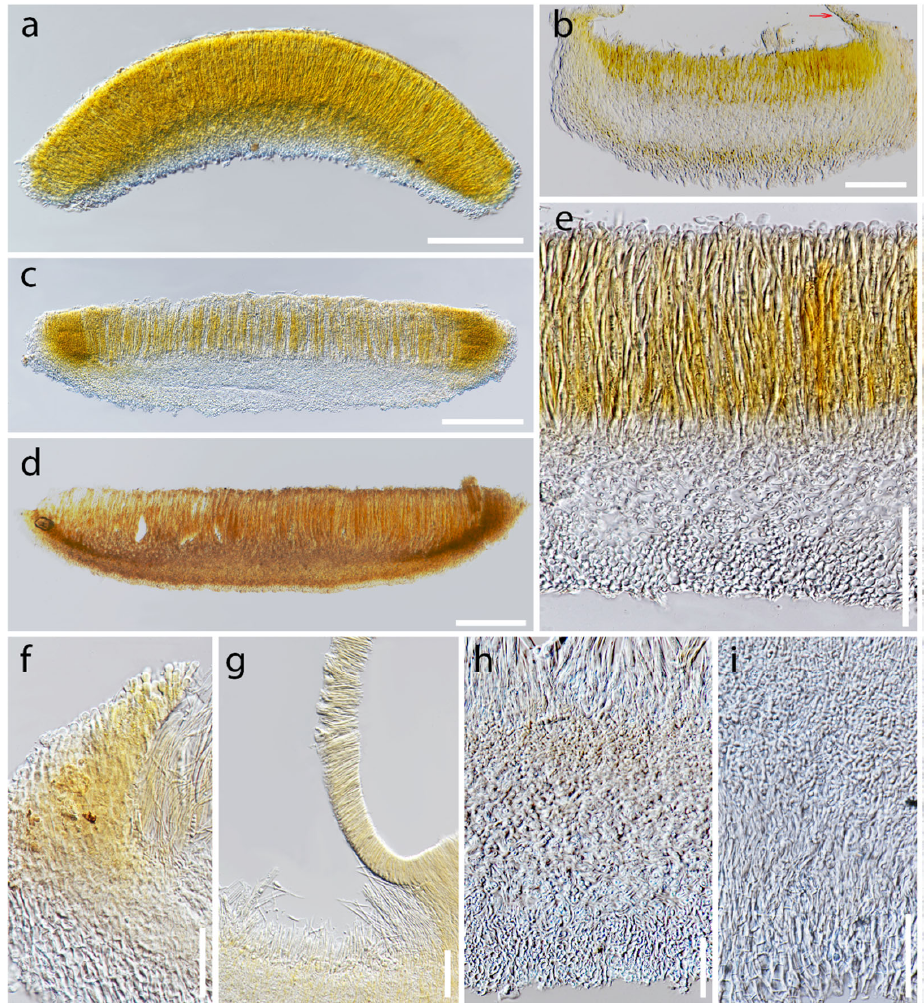
Figure 9. Apothecial cross sections and excipulum characteristics of Dicephalospora rufocornea . ( a – d ) Cross section of apothecia; ( a ) MFLU 19 ‐ 2085; ( b ) MFLU 19 ‐ 2071 arrow pointed out the covered receptacle part; ( c ) MFLU 19 ‐ 2089; ( d ) MFLU 19 ‐ 2073; ( e ) close up of the excipulum (MFLU 19 ‐ 2083); ( f ) margin of the apothecium (MFLU 19 ‐ 2082); ( g ) receptacle covered by apothecium (MFLU 19 ‐ 2071); ( h ) ectal excipulum textura epidermoidea (MFLU 19 ‐ 2073); ( i ) ectal excipulum textura pris ‐ matica (MFLU 19 ‐ 2071). Scale bars: ( a , c , d ) = 200 μ m; ( b , e ) = 100 μ m; ( f – i ) = 50 μ m.